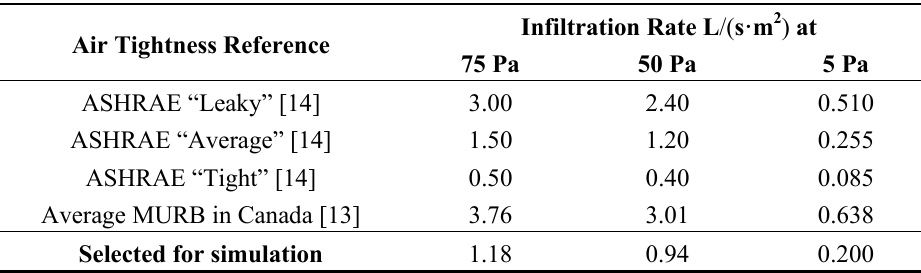
Table 3. Air infiltration